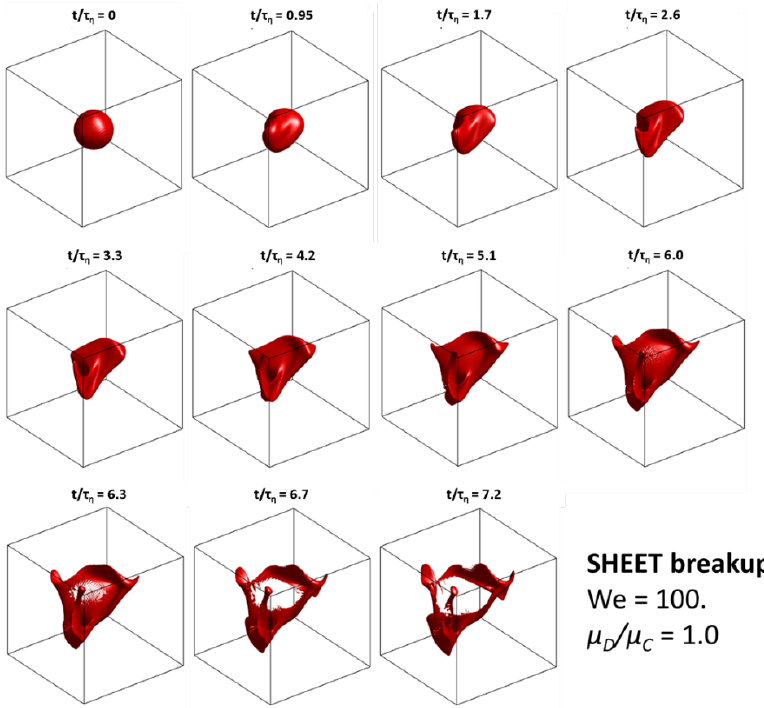
Figure 1. Breakup sequence for We = 100, µ D / µ C = 1. Illustrating the sheet breakup morphology. (Iso-surfaces at α = 0.5).